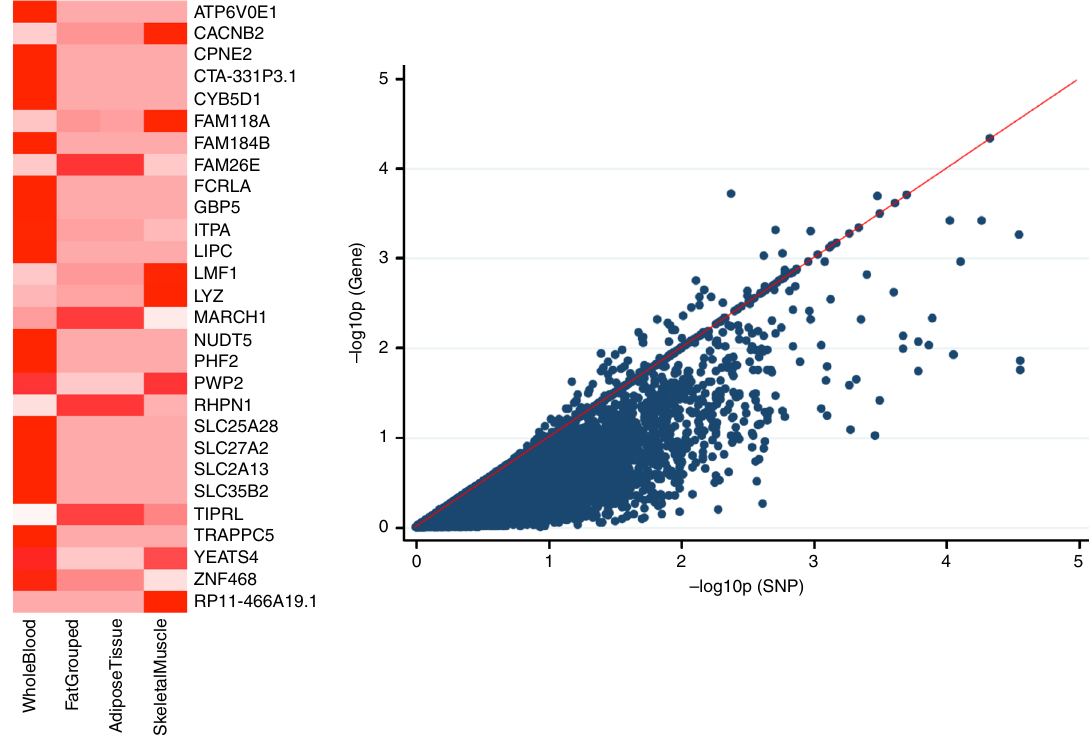
Fig. 7 Signi fi cant genes on integrative GWAS and transcriptomic analysis. a Displays genes with gene-set p < 10 − 3 colored in deep red. Transcriptomic data from whole blood (11 studies), “ Fat Grouped ” (Grundberg et al. 73 and GTeX adipose tissue), adipose tissue (GTeX adipose tissue only), skeletal muscle (GTeX skeletal muscle only). b Plot of gene-based versus best single variant association p values for whole